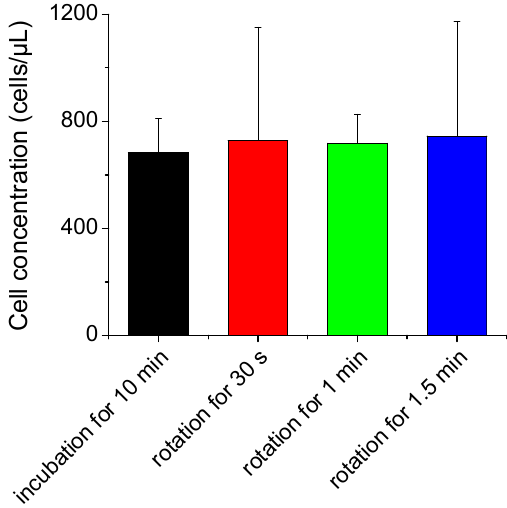
Figure 6. Measured concentrations of CD4 cells labeled with antibodies using the conventional incubation method and nut-and-bolt microfluidic mixing method that induces a chaotic advection within the reaction chamber by applying bidirectional rotation of the sample cartridge at 1000 rpm.